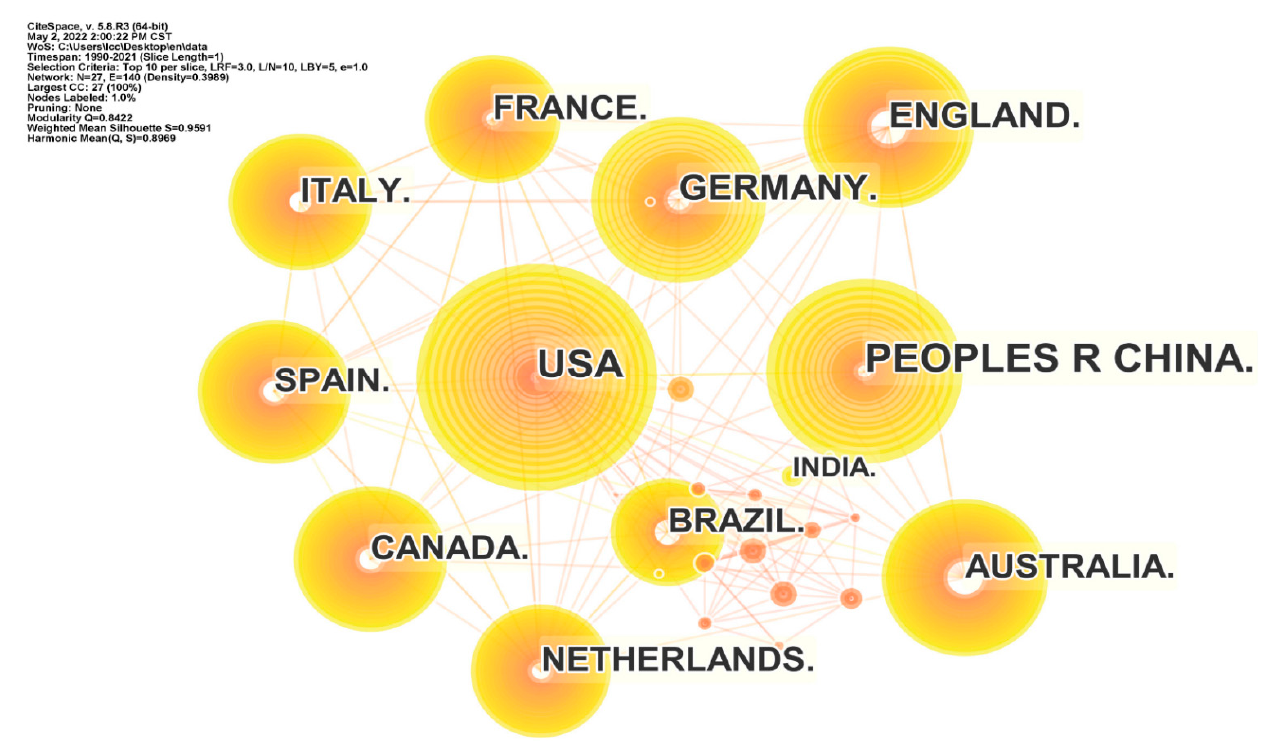
Figure 4. Map of the high–yield country cooperation network.